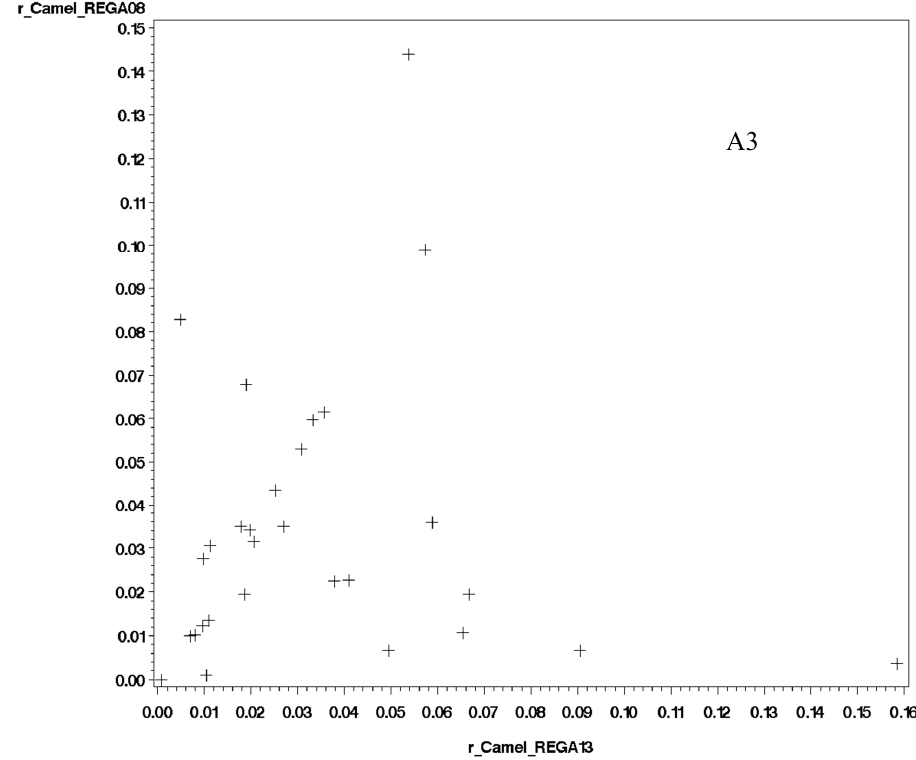
Figure A1. Scatter plots of relative number of heads for camels (A1–A3).